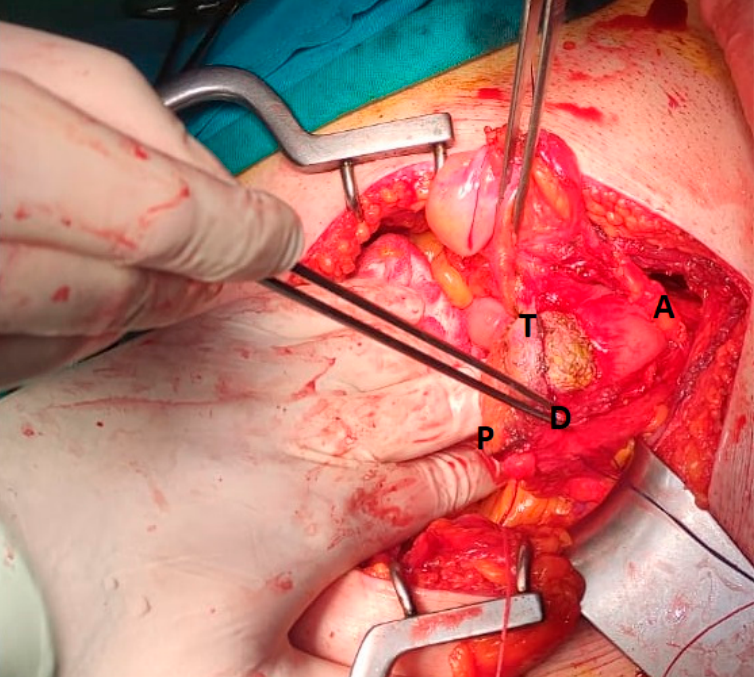
Figure 3. Intraoperative finding and the performance of the tumour resection from the dome of the urinary bladder. A—anterior wall of the urinary bladder; D —the dome of the urinary bladder; P—posterior wall of the urinary bladder; T—tumour.